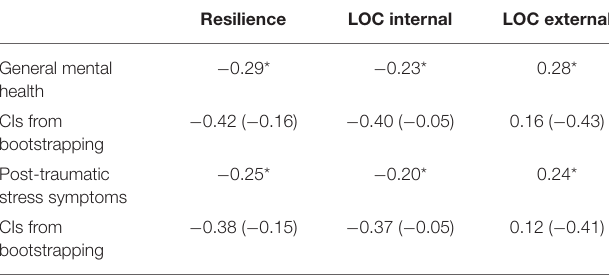
TABLE 6 | Indirect effects ( β ) of general resilience and LOC on general mental health problems and post-traumatic stress symptoms. Resilience LOC internal LOC